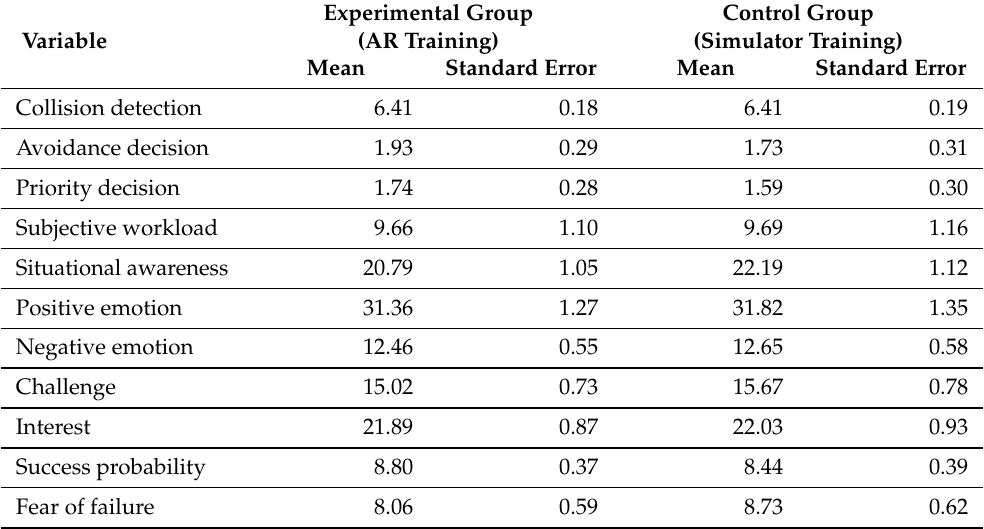
Table 3. Descriptive data of trainees’ performance, workload, situational awareness, emotion and